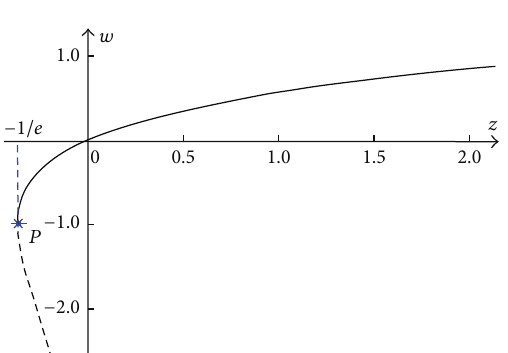
Figure 2: Illustration of OEB bifurcation.